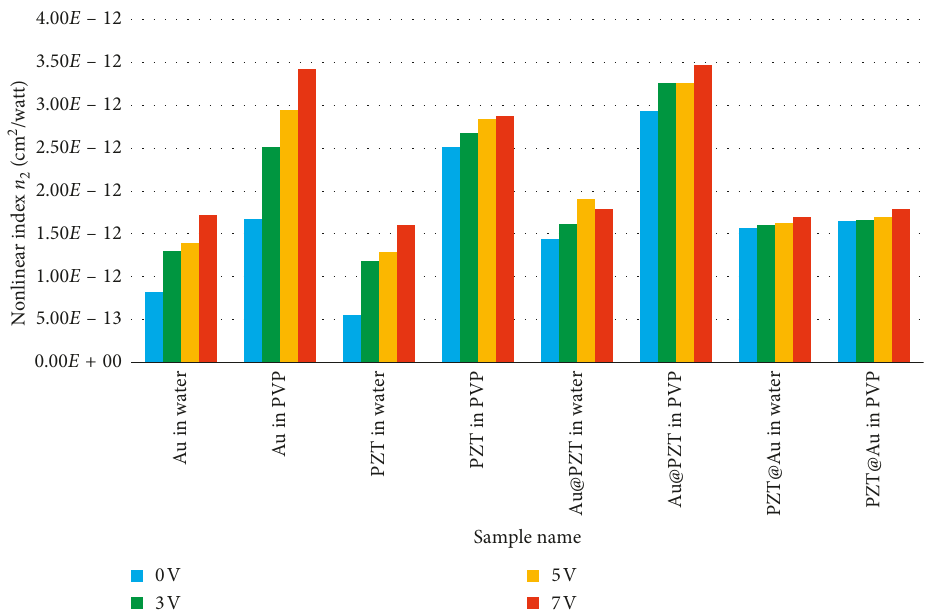
Figure 11: Effect of voltages on the nonlinear refractive index for different samples.